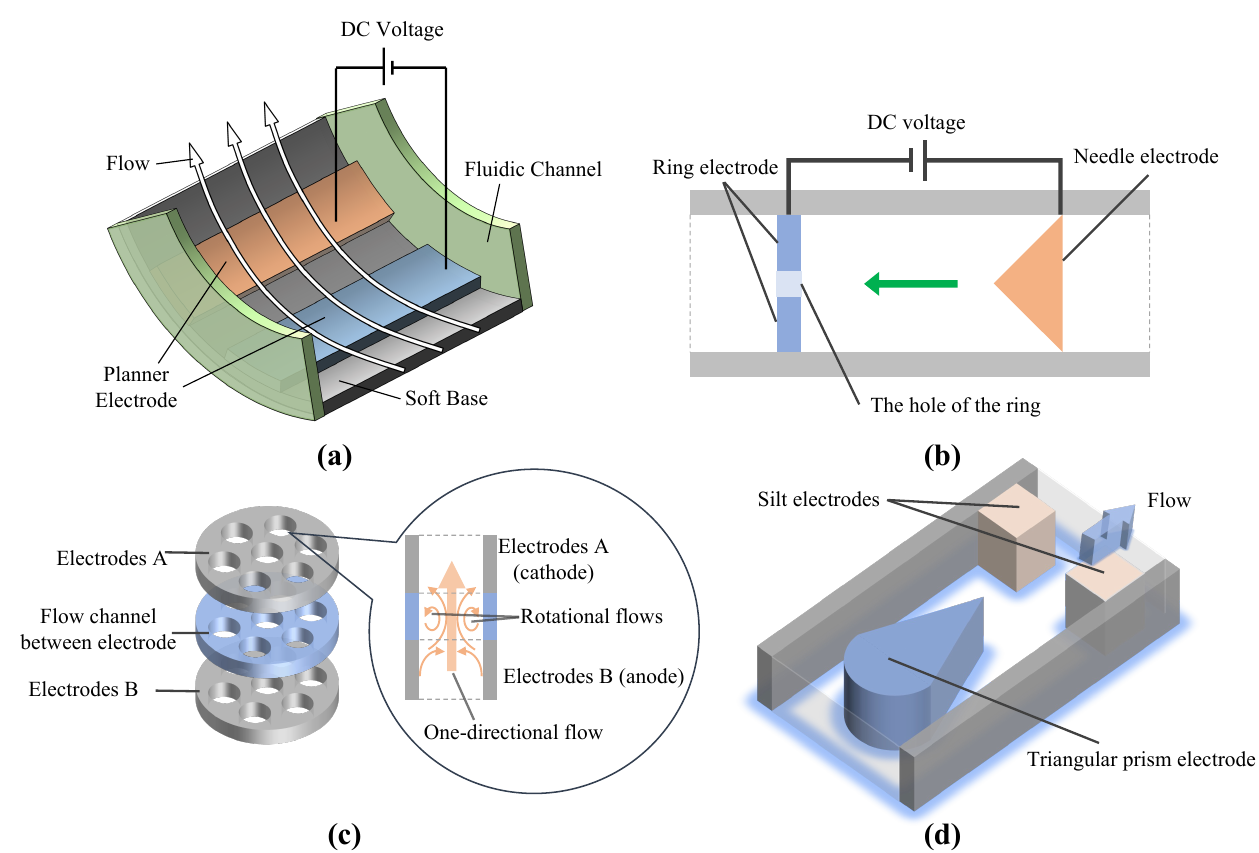
Figure 4. Schematic of functional fluidic EHD pump with various electrode types. ( a ) Planar electrodes [38]. ( b ) Needle-to-ring electrodes [52]. ( c ) Disk electrodes [53]. ( d ) Triangular prism-to-silt electrodes